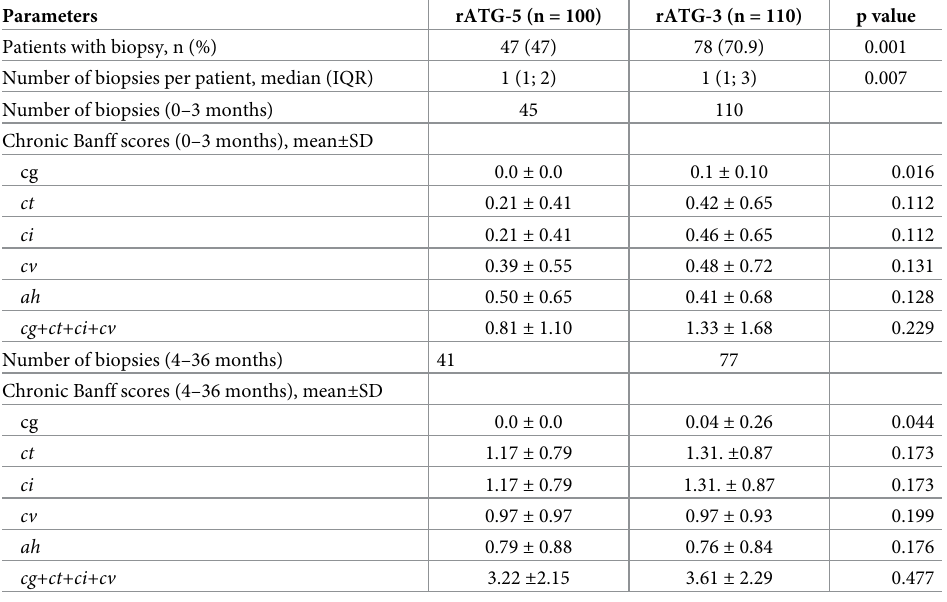
r-ATG: rabbit antithymocyte globulin; IQR: interquartile range; SD: standard deviation; cg: glomerular basement membrane double contours; ct: tubular atrophy; ci: interstitial fibrosis; cv: vascular fibrous intimal thickening; ah: arteriolar